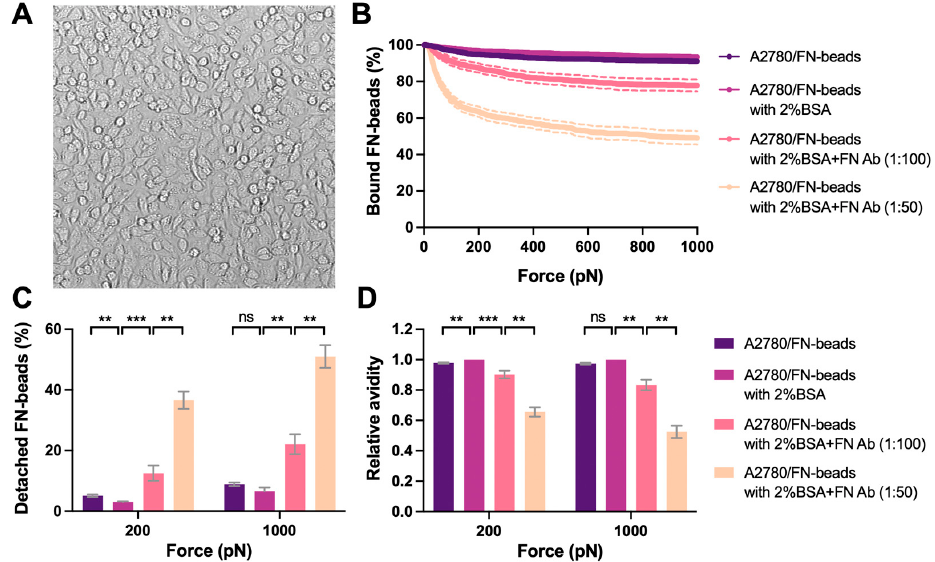
Figure 5. Avidity measurement of tumor cell monolayer interacting with ECM coated beads. ( A ) A2780 cells were seeded at the density of 50 × 10 6 cells/mL. A stable monolayer was formed after 1 hr incubation at 37 °C. After validation the monolayer was used as the ‘Target’. The representative image of the monolayer was shown. FN proteins were coated on the beads as the ‘Effector’. 2% BSA was used in the complete medium to block the non-specific binding. The FN antibody was used to treat the FN-beads at 1:100 or 1:50 dilutions for 1 h to block its interaction with the ‘Target’. The ‘Effectors’ pre-treated with indicated conditions were flushed into the flow chamber and interacted with the ‘Targets’ for 2.5 min before the acoustic force was applied. ( B ) The percentage of ‘Effectors’ bound to ‘Targets’ under the force from 0 to 1000 pN was measured and analyzed to indicate the avidity. ( C ) The percentage of detached ‘Effectors’ under each treatment conditions at 200 pN and 1000 pN of force was plotted. ( D ) The avidity relative to that of A2780/FN-beads with 2% BSA was calculated and presented. Data were collected from at least three independent experiments. Error bars are mean ± S.E.M.; ns = not significant; ** p < 0.01; *** p < 0.001, assessed by unpaired